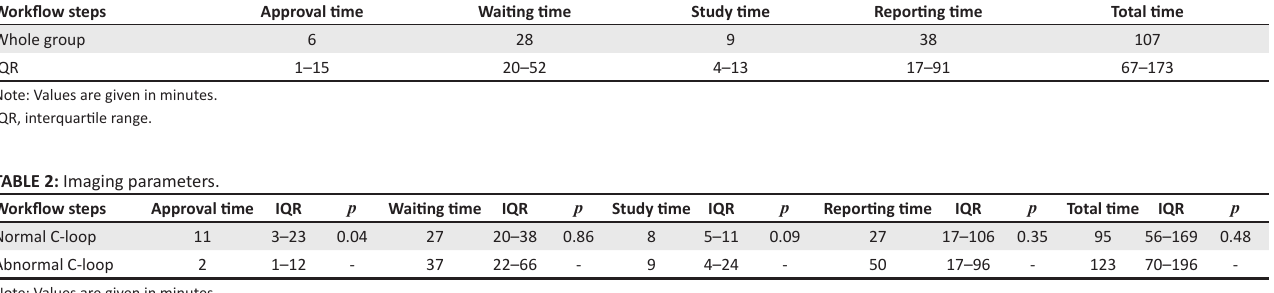
TABLE 1: Whole group. Workflow steps